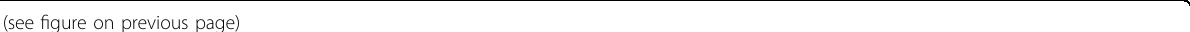
Fig. 6 Knockdown of miR-200b or miR-200c partially reverses the effect on proliferation, but reverses the effect on migration and invasion. a In the HT29 cell line, there is no difference in cell proliferation following dual ZFAS1 and miR-200b knockdown compared to non-target siRNA, when measured by doubling time ( p = 0.46), but there is more rapid proliferation with dual knockdown of ZFAS1 and miR-200c compared to non-target siRNA (*doubling time: 26.8 h vs. 30.6 h, p = 0.01) ( n = 6 replicates). b In the SW480 cell line, cell proliferation following dual ZFAS1 and miR-200b knockdown is slower than compared to non-target siRNA (**doubling time: 35.9 vs. 30.5, p = 0.06), but there was no difference in proliferation with dual knockdown of ZFAS1 and miR-200c compared to non-target siRNA ( p = 0.55) ( n = 6 replicates). c , d In the HT29 and SW480 cell lines, there is no difference in the transwell migration with both ZFAS1 and miR-200b or ZFAS1 andmiR-200c knockdown compared to non- target siRNA (all p > 0.05) ( n = 6 replicates), The panels on the right of each fi gure show representative ×10 magni fi cation fi elds of the HT29 and SW480 cell lines transwell migration assay (top panel ZFAS1 knockdown + miR-200b antagomir, middle panel ZFAS1 knockdown + miR-200c antagomir, bottom panel non-target siRNA). e , f In the HT29 and SW480 cell lines, there was no difference in the transwell invasion with both ZFAS1 and miR-200b or ZFAS1 and miR-200c knockdown compared to non-target siRNA (all p > 0.05) ( n = 6 replicates). The panels on the right of each fi gure show representative ×10 magni fi cation fi elds of the HT29 and SW480 cell lines transwell migration assay (top panel ZFAS1 knockdown + miR- 200b antagomir, middle panel ZFAS1 knockdown + miR-200c antagomir, bottom panel non-target siRNA). g In the HT29 cell line, there was no difference in scratch closure in both ZFAS1 and miR-200b or ZFAS1 and miR-200c knockdown compared to non-target siRNA (all p > 0.05) ( n = 6 replicates). The panels on the right show representative ×4 magni fi cation fi elds of the HT29 scratch assay (top panels scratch closure following dual ZFAS1 and miR-200b knockdown at time 0 and at 120 h, middle panels scratch closure following dual ZFAS1 and miR-200c knockdown at time 0 and 120 h, bottom panels scratch closure with non-target siRNA at time 0 and at 120 h). h In the SW480 cell line, there was no difference in scratch closure in both ZFAS1 and miR-200b or ZFAS1 and miR-200c knockdown compared to non-target siRNA (all p > 0.05) ( n = 6 replicates). The panels on the right show representative ×4 magni fi cation fi elds of the SW480 scratch assay (top panels scratch closure following dual ZFAS1 and miR-200c knockdown at time 0 and at 48 h, middle panels scratch closure following dual ZFAS1 and miR-200c knockdown at time 0 and 48 h, bottom panels scratch closure with non-target siRNA at time 0 and at 48 h).